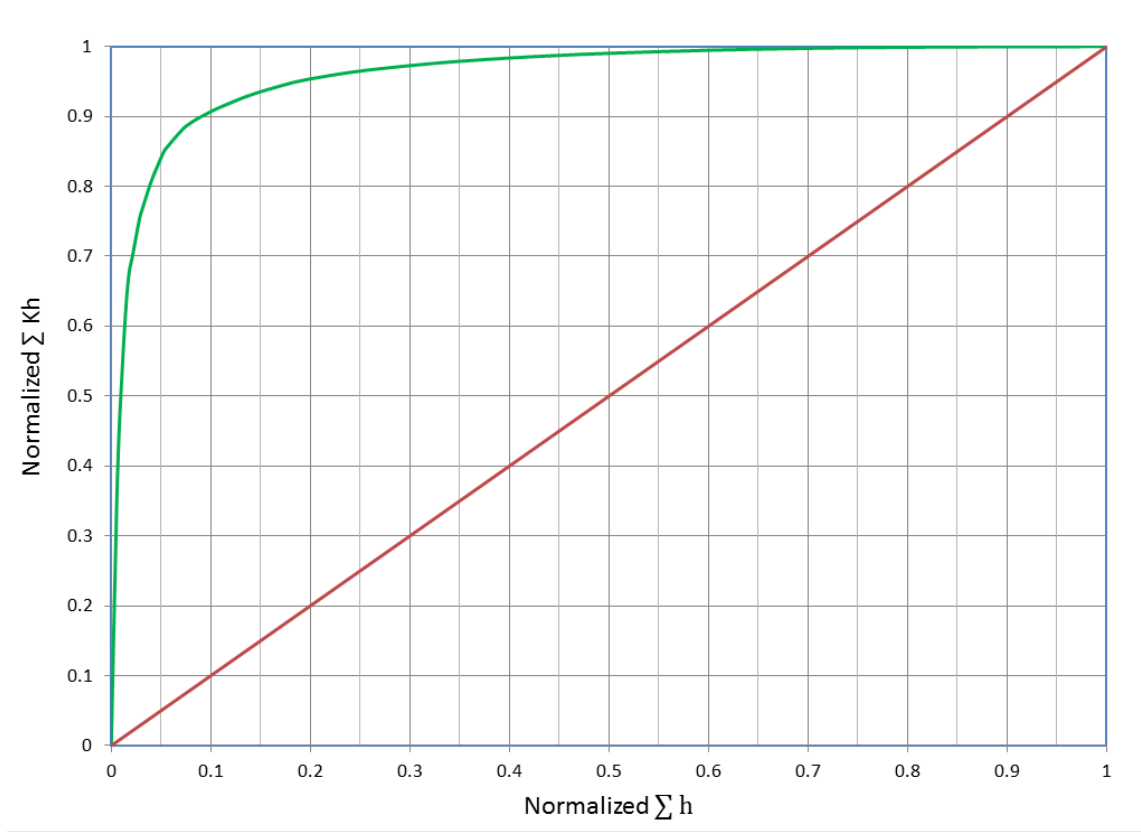
Figure 2. Normalized flow capacity to Upper Bahariya